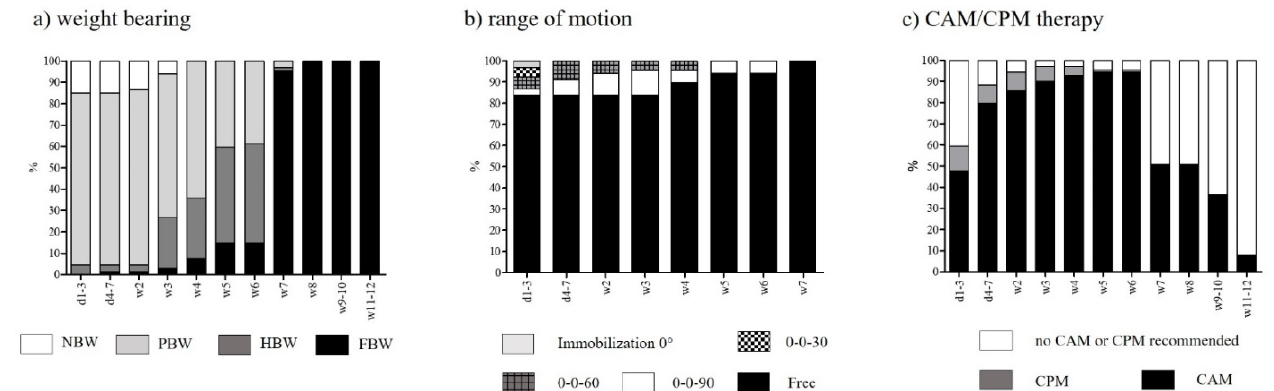
Figure 3. Early rehabilitation phase after femorotibial MFX concerning ( a ) weight-bearing, ( b ) range of motion, and ( c ) motion therapy, expressed as the percentage of protocols. NBW: no body weight; PBW: partial body weight; HBW: half body weight; FBW: full body weight; CAM: continuous active motion; CPM: continuous passive motion; d: day; w: week.